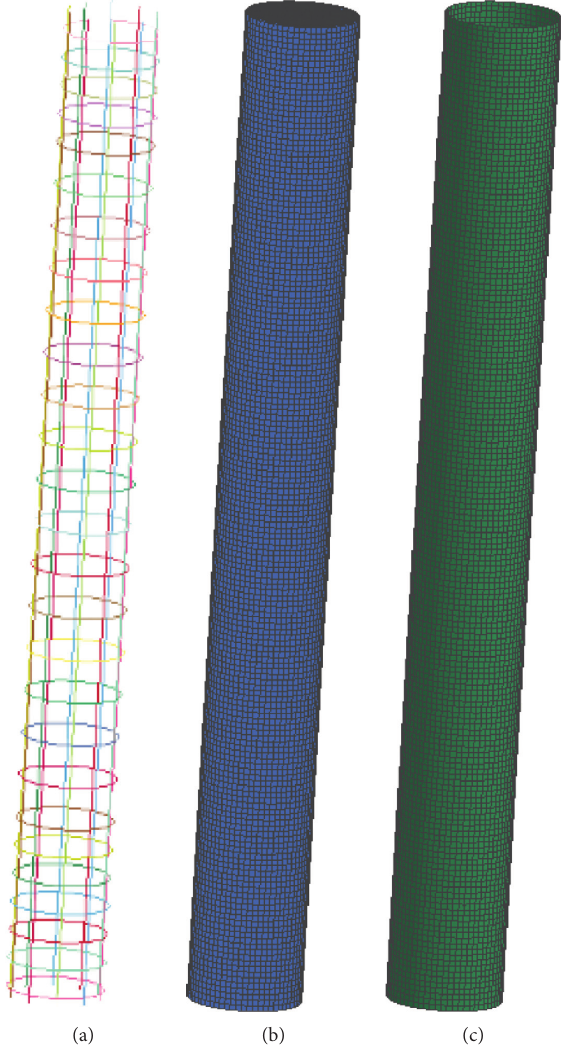
Figure 7: Finite element model of tested column. (a) Rebar. (b) Concrete. (c)